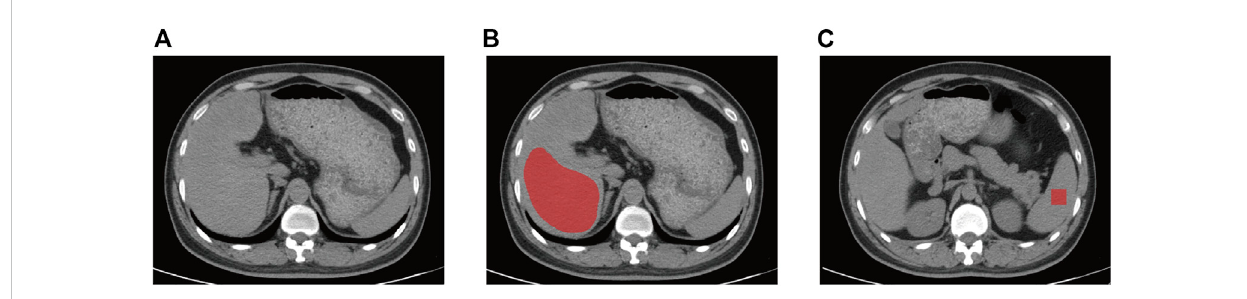
FIGURE 2 Non-contrastCTimageofa42-year-old manwithmildliversteatosis.TheROIofliver (A) andspleen (B) isindicatedbytheredarea.TheROIofliver was delineated along the margin of the right hepatic lobe at the level of right portal vein by avoiding large hepatic vessels and the ROI for spleen is 4 cm 2 square of two contiguous sections. CT, computed tomography, ROI, region of